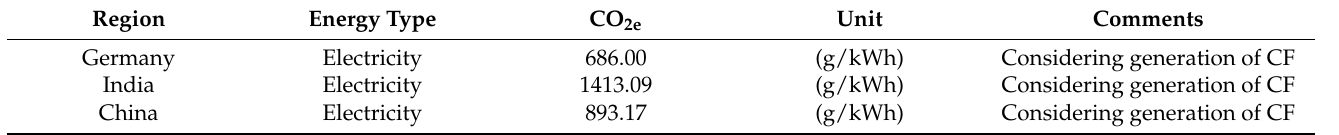
Table 11. GHGs generated by electricity generation in each concerned country